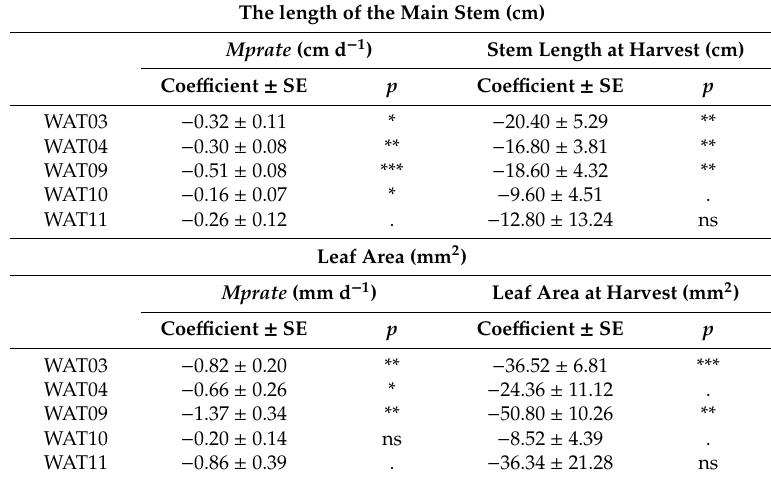
Table 2. Analysis of variance on effects of applied treatment on growth curve characteristics and phenotypic traits at harvest of drought-stressed miscanthus genotypes compared to controls; mprate—the mean progression rate of the growth curve; SE—measure of the uncertainty in the coefficient; p -value indicates the statistical significance for a given term within the model. Significance of differences are shown as p ≤ 0.1; * p ≤ 0.05; ** p ≤ 0.01; *** p ≤ 0.001; ns = not significant.